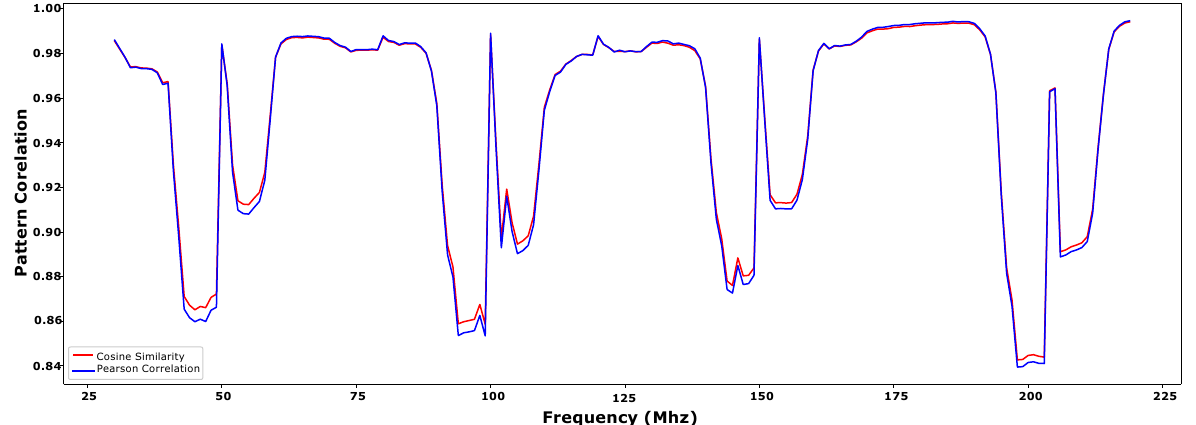
Figure 3. Cosine similarity (red) and Pearson correlation (blue) for the two traffic patterns across the frequencies analysed.